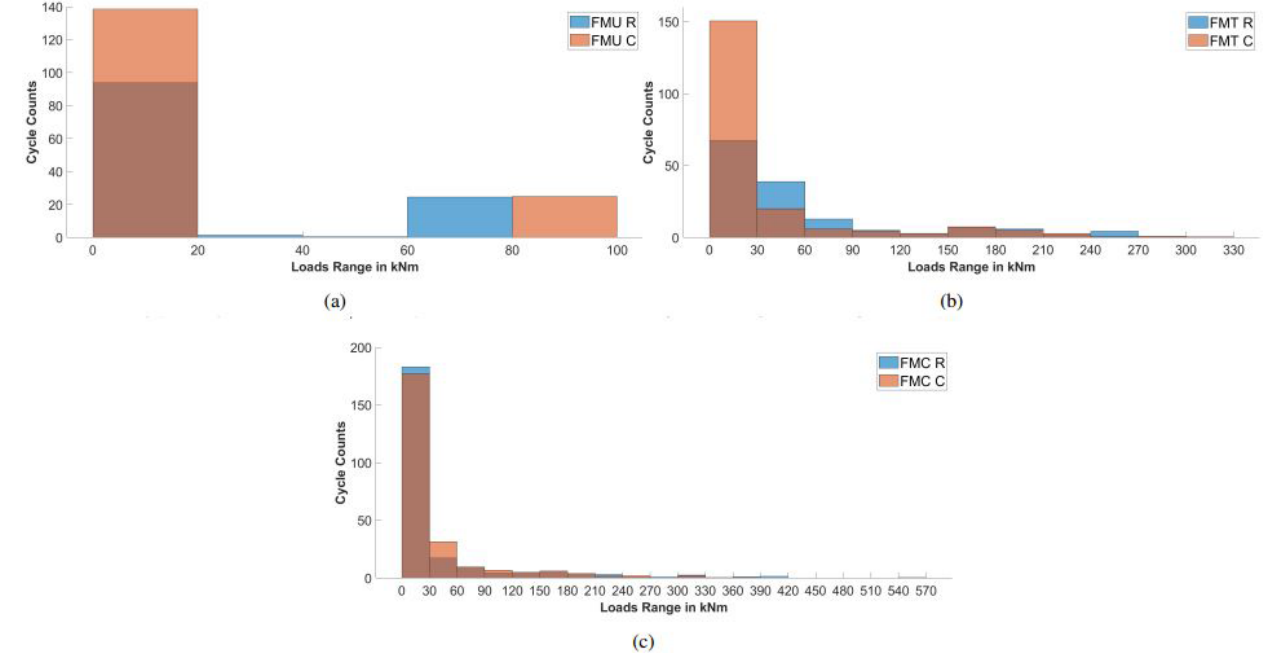
Figure 14. Cycle count using the bending moment M y for the cases FMU, FMT and FMC, both rigid and shell-based